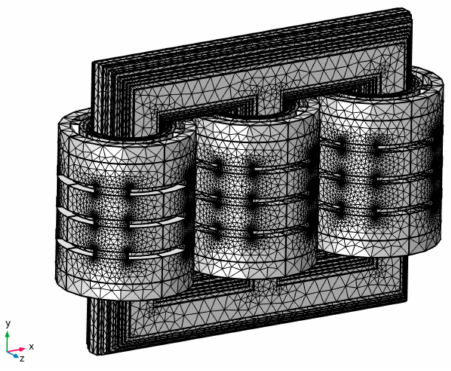
Figure 2. Transformer grid